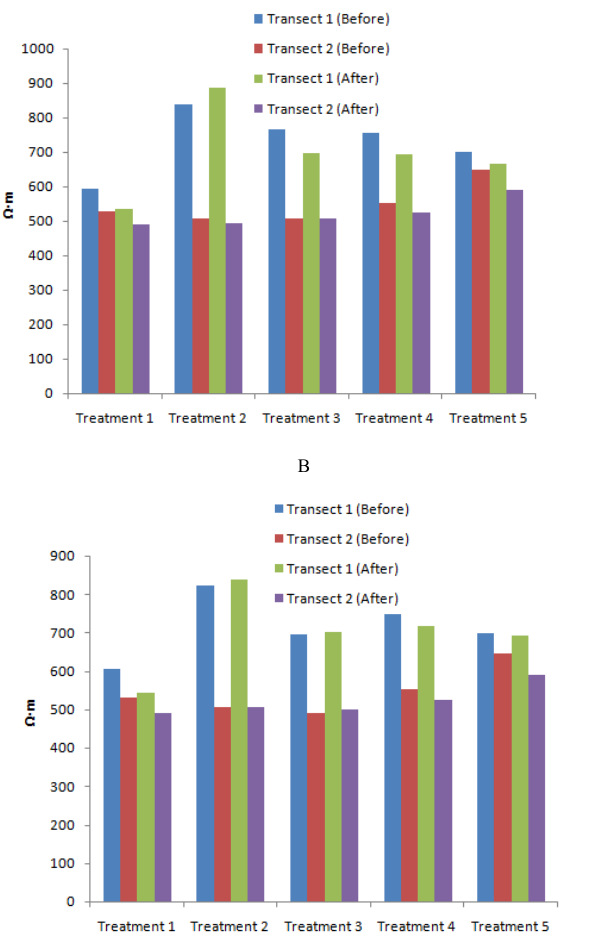
Figure 7: Electrical Resistivity means in the 2 transects and the 5 treatments, before and after operations, at 0.08 m (A) and 0.23 m (B) soil depths